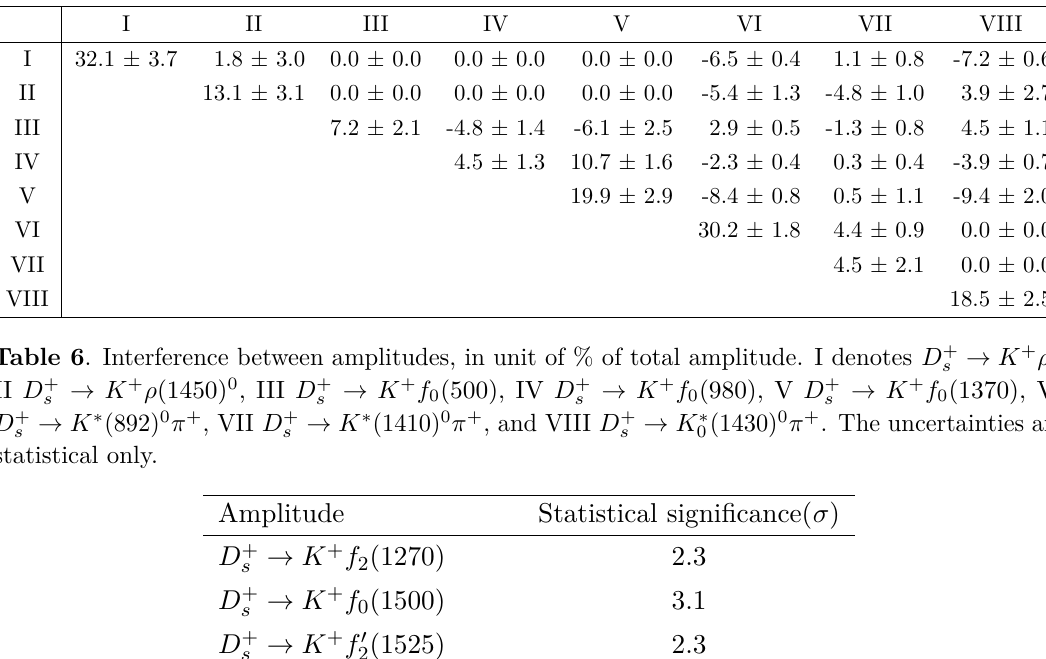
Table 7 . Statistical significances for amplitudes tested, but not included in the nominal